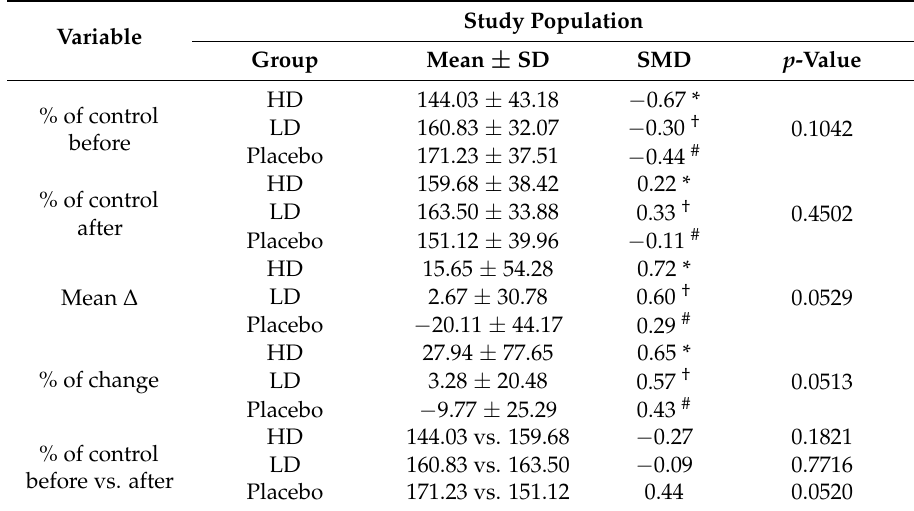
Table 4. The proliferation grade of human umbilical vein endothelial cells (HUVEC) exposed for 24 h to serum derived from the high dose (HD), low dose (LD), and placebo groups before and after the intervention, estimated by an in vitro MTT colorimetric